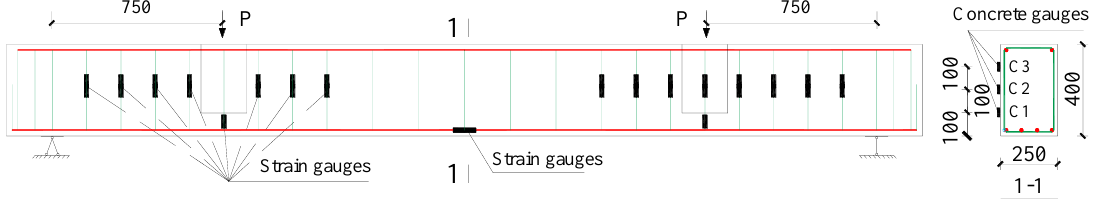
Figure 6. Loading and strain gauges for beams (dimensions in mm).